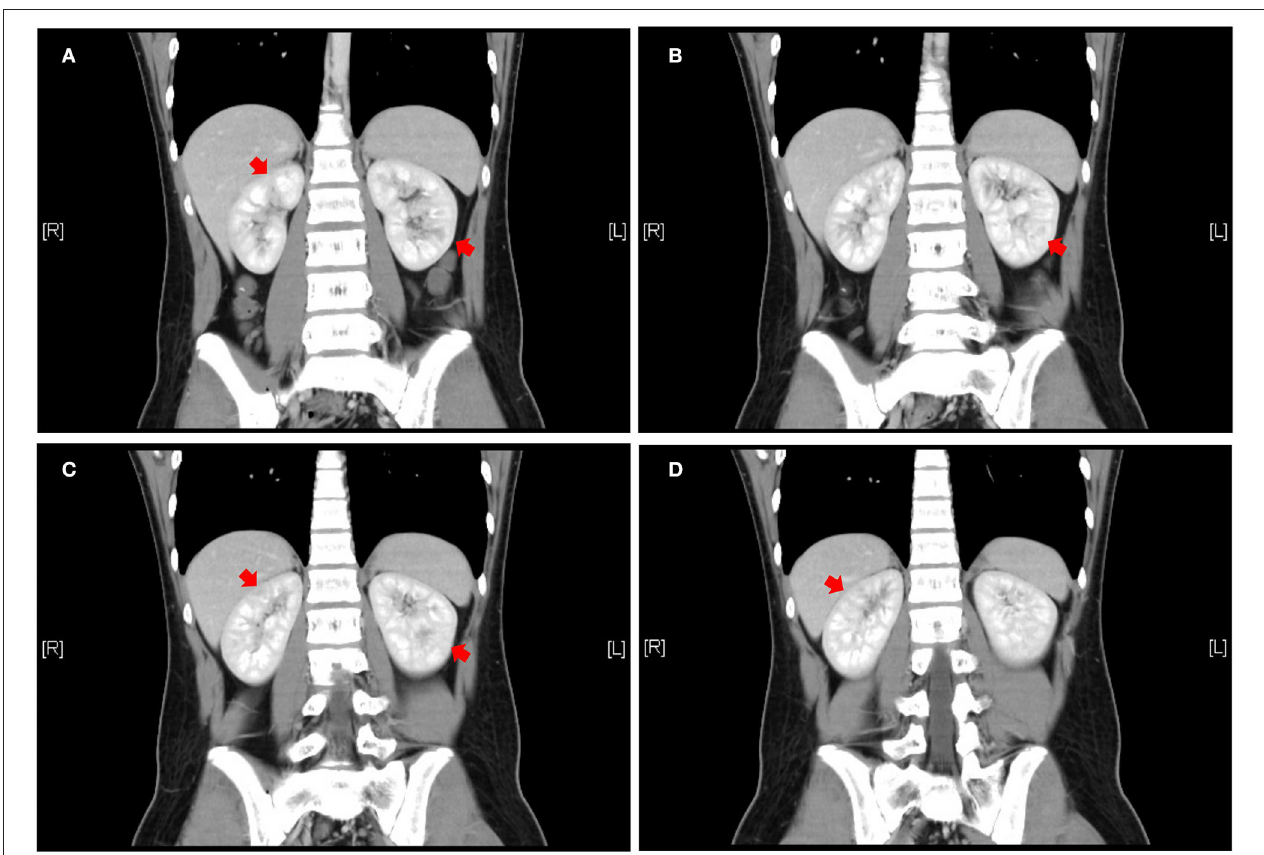
FIGURE 1 | Abdominal enhanced CT coronal view, front to rear, numbered A to D . Patchy and slightly less enhanced areas are seen in both kidneys (red arrows). CT = computed tomography to illustrate the meaning of A–D